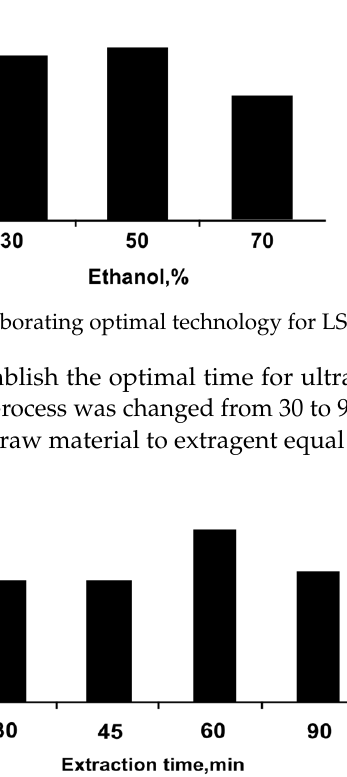
Figure 3. Elaborating optimal technology: choosing extraction time for LS-2.